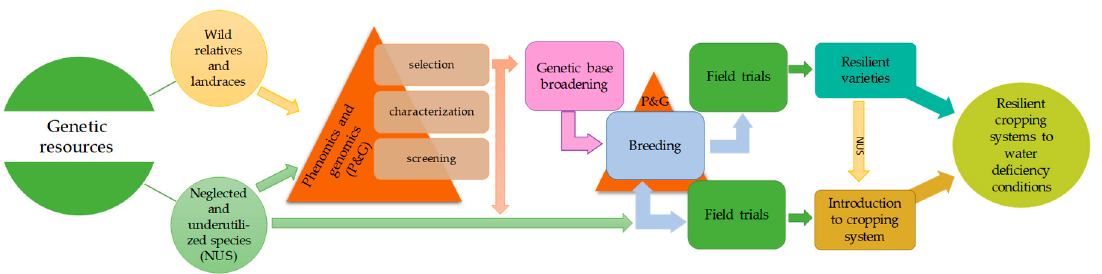
Figure 1. Dual strategy of breeding for drought tolerance and the introduction of underutilized crops to make more resilient cropping systems to water deficiency conditions.